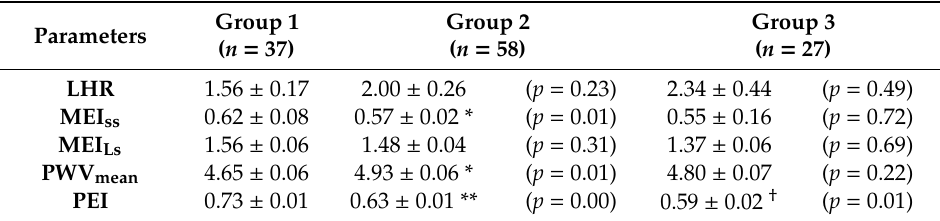
Table 2. Of computational parameters for autonomic function assessment in three groups of testing